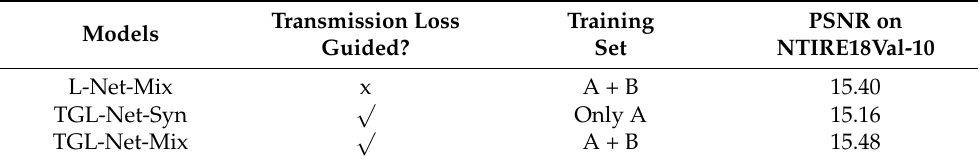
Table 9. Ablation study settings. Training set A is a synthetic haze set generated from the NYU dataset, and training set B is an augmented real haze set from the NTIRE 2018 dataset.